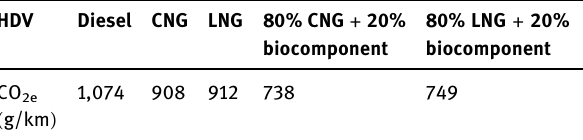
Table 1: Well - to - wheel CO 2e ( g/km ) [ authors based on ref. [ 45 ]]